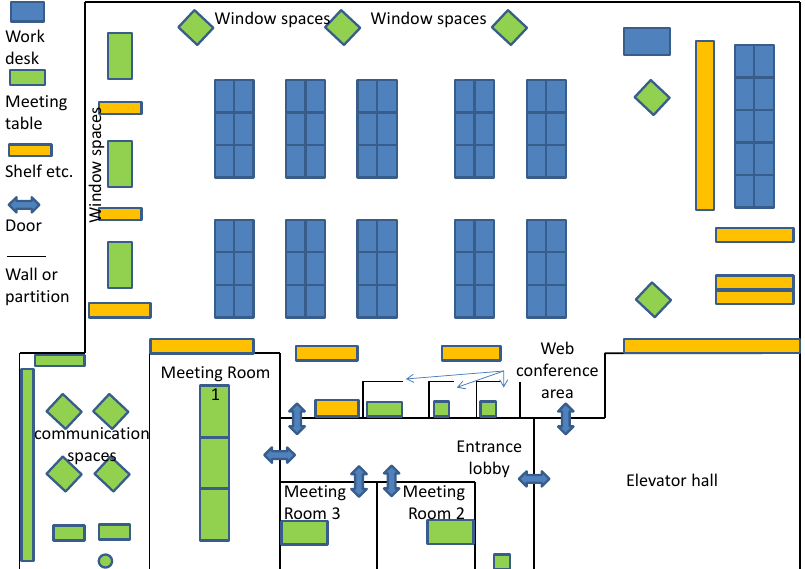
Figure 1. The layout of the new